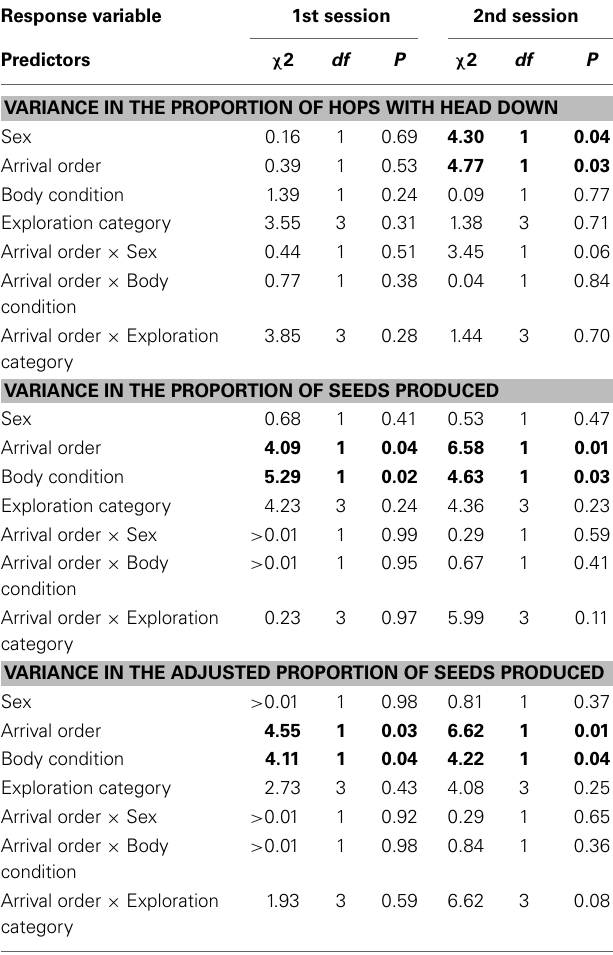
Table 1 | Results of the models testing the factors affecting